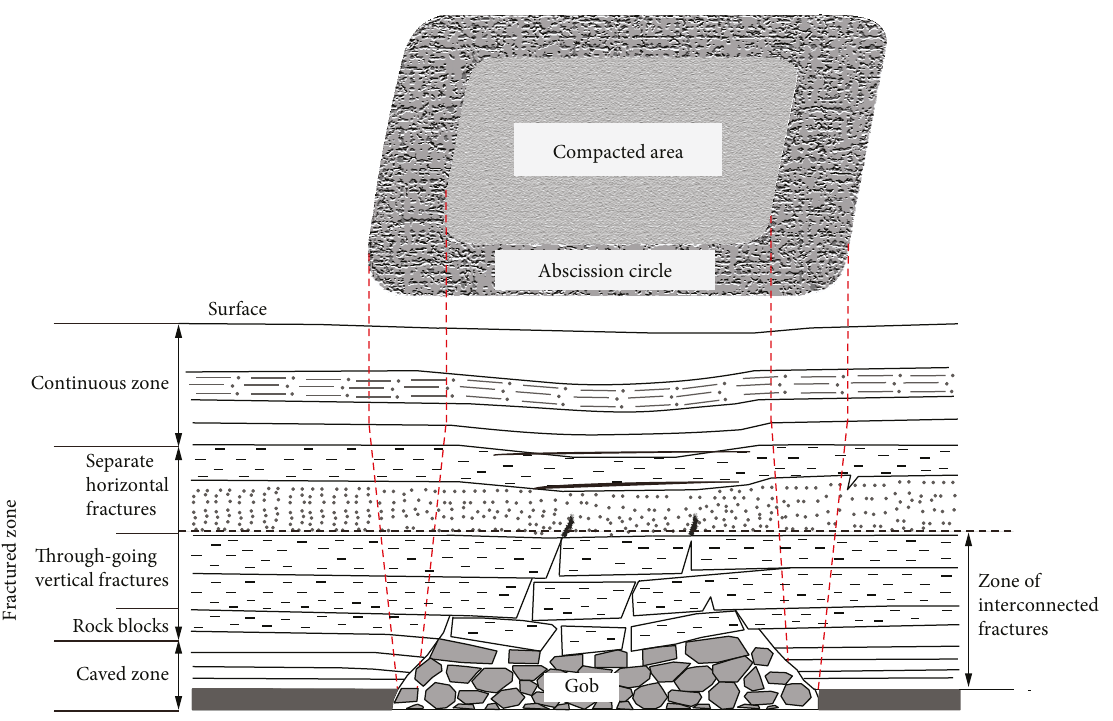
Figure 9: Schematic diagram of the “ three zones ” [19, 41] and “ abscission circle ” [30, 42].